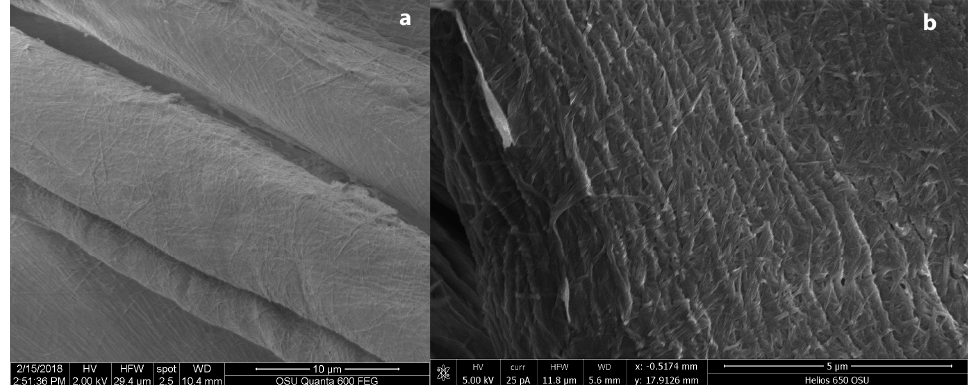
Figure 9. ( a ) Cotton printed CTAB-based ink, image taken with a FEI Quanta 600; ( b ) Detail of the surface of the CTAB-based ink printed cotton surface. Image taken with a FEI Helios 650.